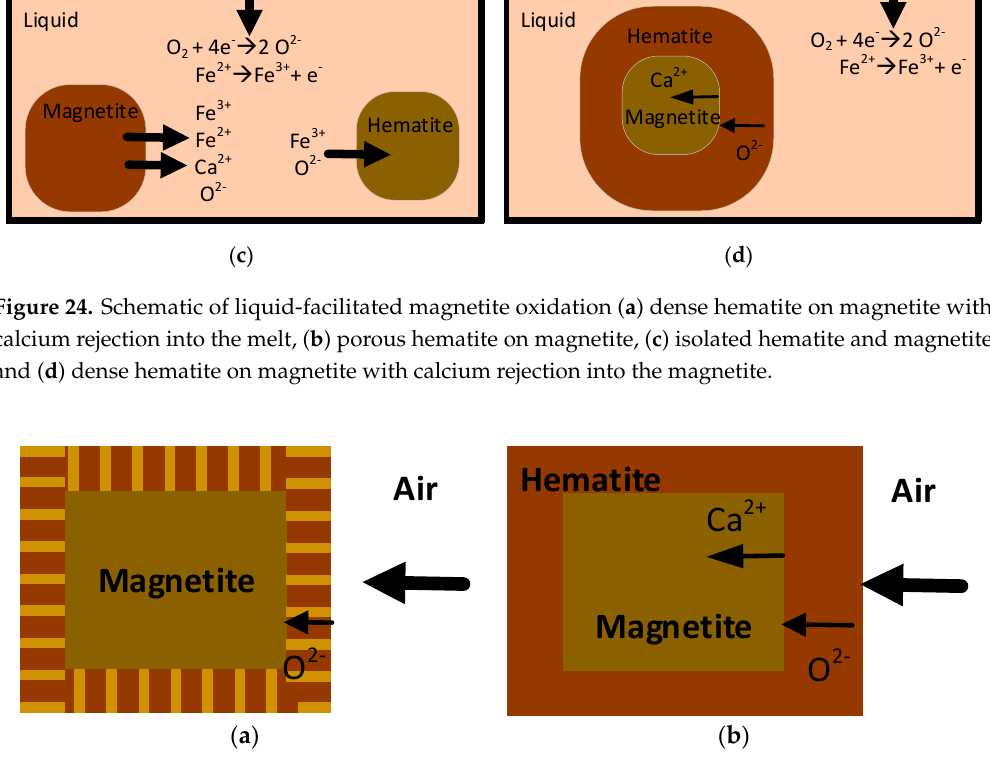
Figure 25. Schematic of solid state oxidation, ( a ) coupled growth of hematite and a calcium ferrite and ( b ) rejection of Ca 2+ into the centre of the secondary hematite leading to the formation of a calcium ferrite.